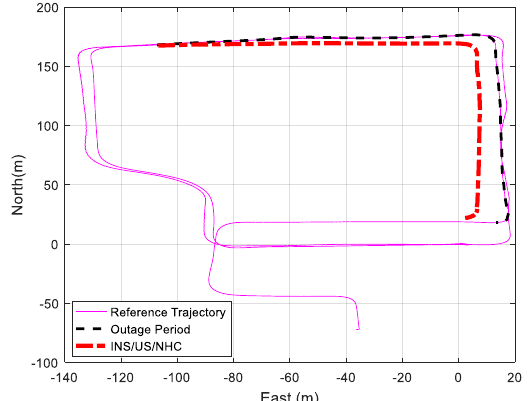
Figure 22. Second trajectory INS/Ultrasonic velocity